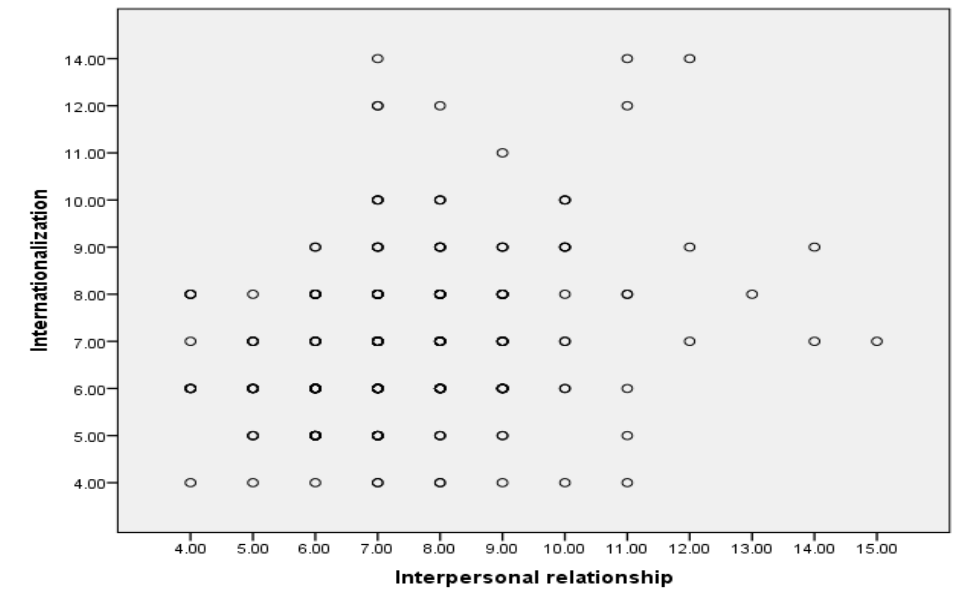
Fig. 2. Scatter plot of interpersonal relationship and internationalisation scores (The Authors’ Fieldwork Computation,